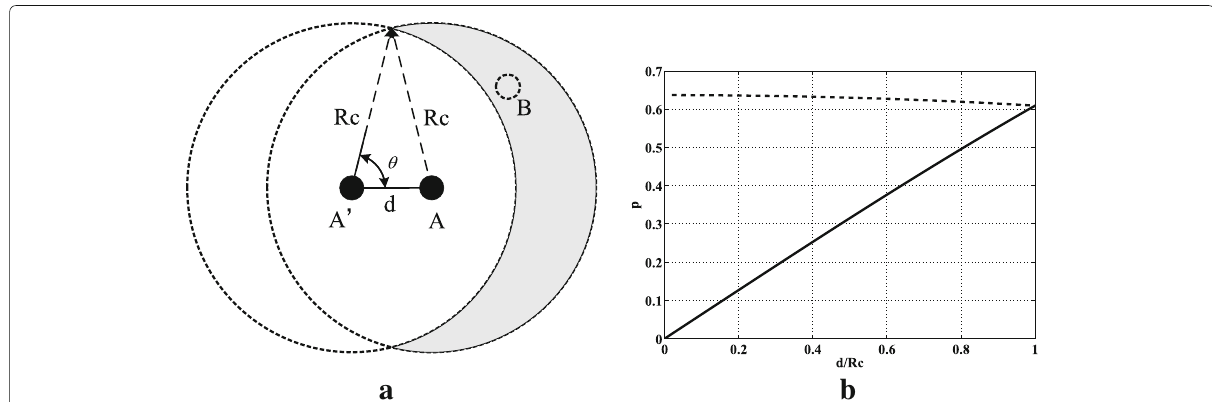
Fig. 8 The influence of node moving distance. a An example of the influence of node moving. b The influenced probability of a node against